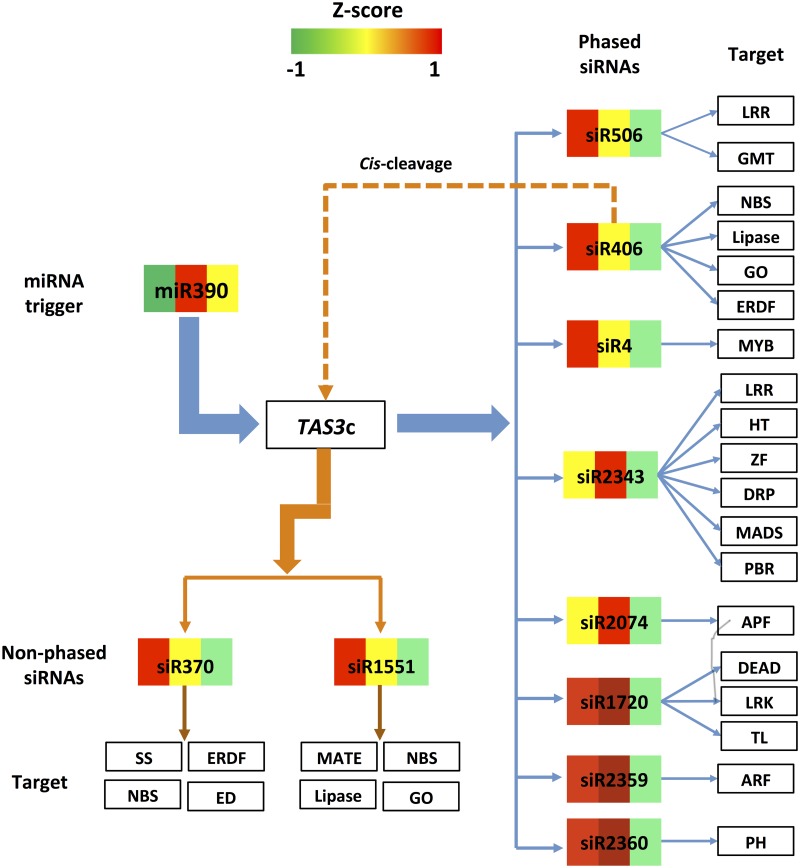
miR390-directed pha-siRNA regulatory pathway.The miR390 directed pha-siRNA regulatory pathway is shown as indicated. The blue arrows and lines show the regulatory pathway of pha-siRNA s produced from TAS3c, while the dark orange arrows and lines show the regulatory pathway of cis-cleavage by pha-siRNA, siR406. The colors in the boxes from left to right represent the Z-score of expression values of sRNAs in the leaf, flower and boll, respectively. LRR: Leucine-rich repeat family protein; GMT: DP-mannose transporter; NBS: NBS-LRR disease resistance protein; Lipase: Lipase; GO: Glycolate oxidase; ERDF: Early-responsive to dehydration family protein; MYB: MYB transcription factor; HT: hexose transporter; ZF: Zinc finger family protein; DRP: DNA-directed RNA polymerase family protein; MADS: MADS-box transcription factor; PRP: Phenylcoumaran benzylic ether reductase-like protein; APF: Amino acid permease family protein; DEAD: DEAD-box ATP-dependent RNA helicase; LRK: LysM type receptor kinase; TL: Temperature-induced lipocalin; ARF: Auxin response factor; PH: Pleckstrin homology domain-containing family protein; SS: Spermidine synthase; ED: Elongation defective 1 family protein; MATE: MATE efflux family protein.